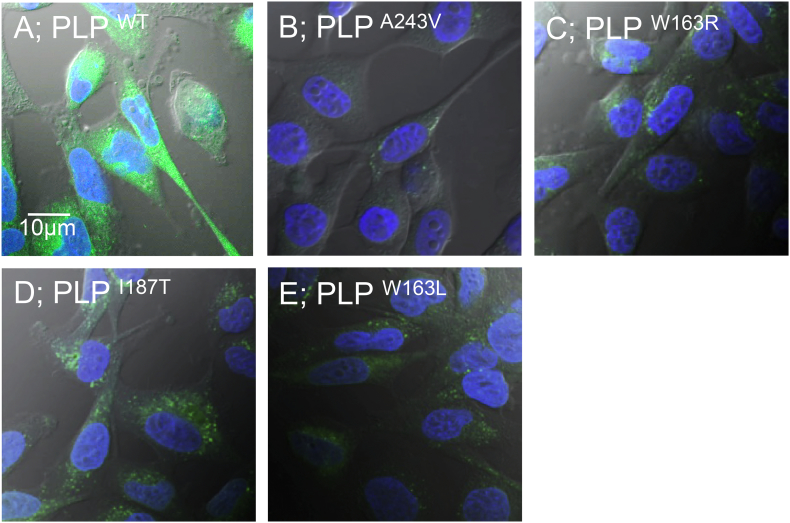
The results of measuring the expression and intracellular localization of wild and mutant types of PLP1-EGFP, images of MO3.13 cells stably expressing PLP1 wild-type (Panel A) and four types of PLP1 mutants fused with EGFP: PLP1A243V (B), PLP1W163R (C), PLP1I187T (D), and PLP1W163L (E) are shown. Fused EGFP protein is shown in green, and Hoechst-stained nuclei are shown in blue. Each image was taken by a confocal microscope (magnitude, ×600). PLP1WT was distributed strongly throughout the cells (A). Severe-type mutants (PLP1A243V and PLP1W163R) showed a limited expression, including in the perinuclear region (B, C). Mild-type mutants (PLP1I187T and PLP1W163L) showed an increased expression compared to severe-type mutants but less restricted localization than wild-type specimens (D, E). (For interpretation of the references to colour in this figure legend, the reader is referred to the web version of this article.)